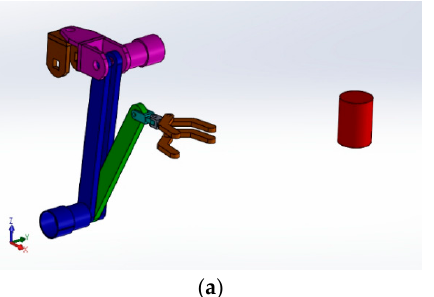
Figure 13. Dynamic simulation of robot arm motion. ( a ) Home position of robot arm; ( b ) position near target.